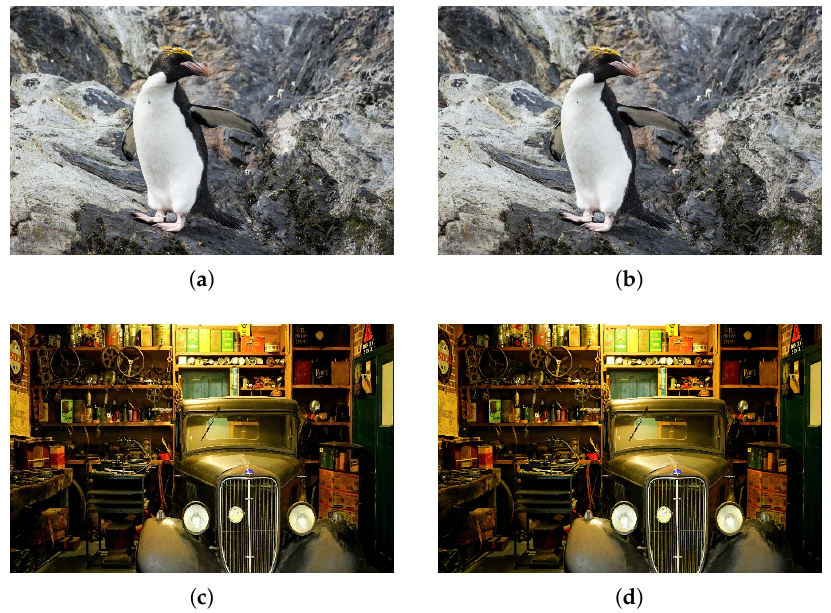
Figure 3. The samples generated by steganography GAN. ( a ) cover image; ( b ) steganographic image; ( c ) cover image; ( d ) steganographic